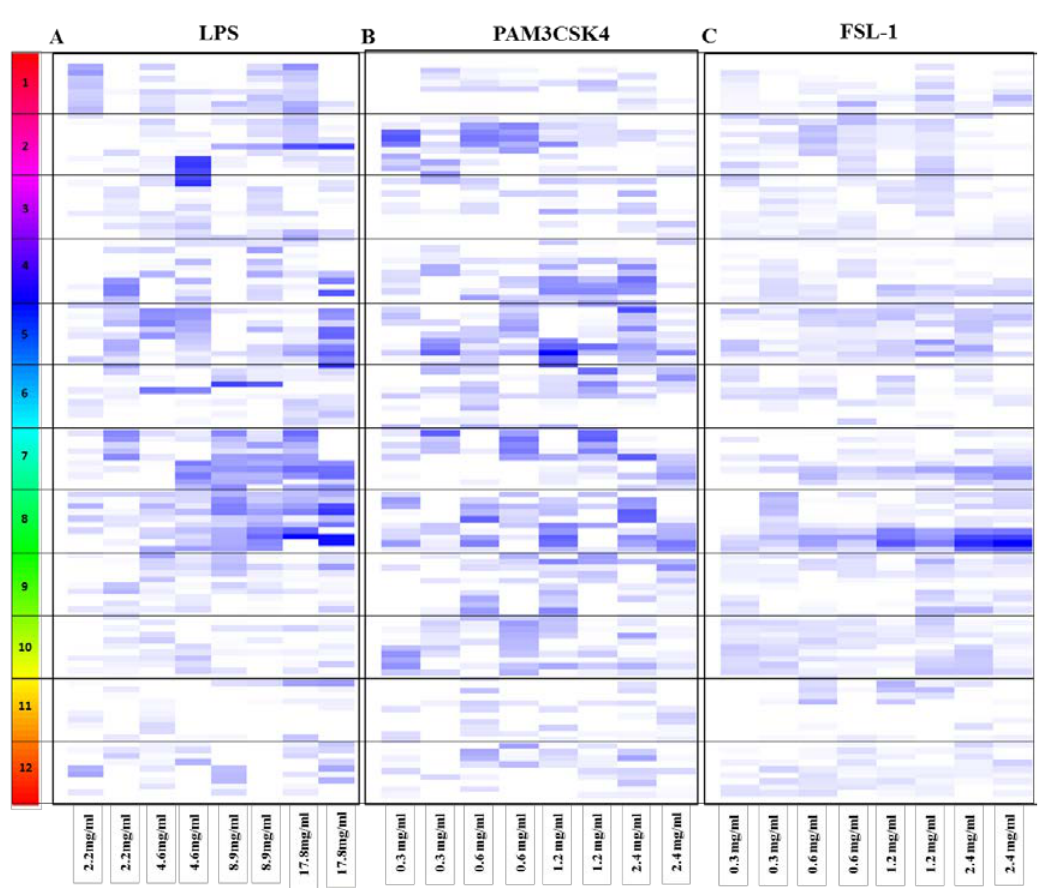
Figure 1. Anti-inflammatory activity score for the individual fruit fractions. Each fruit is represented by a number on the left legend: 1-Pear, 2-Elderberry, 3-Blackcurrant, 4-Red raspberry, 5-Blackberry, 6-Cranberry, 7-Strawberry, 8-Feijoa, 9-Black grapes, 10-Green grapes, 11-Mangosteen and 12-Plum. For each fruit, each row represents a fruit fraction with fraction 11 (hydrophobic) from the top to fraction 2 (hydrophilic) going downwards. Each column represents a concentration. For each concentration there are two biological replicates. The white indicates the fraction was either cytotoxic (Equation (2)) hence excluded from further analyses or had no anti-inflammatory effect. Scale of blue represents the anti-inflammatory score (Equation (1)), light blue (weak anti-inflammatory score) to dark blue (strong anti-inflammatory score). Details of the cytotoxicity scores and anti-inflammatory scores are provided in the supplementary data. ( A ) HEK-Blue hTLR4 (LPS); ( B ) HEK-Blue hTLR2, TLR2/TLR1 (PAM3CSK4) and ( C ) HEK-Blue hTLR2, TLR2/TLR6 (FSL-1) screening. LPS, lipopolysaccharides; PAM3CSK4, Pam3CysSerLys4; FSL-1,